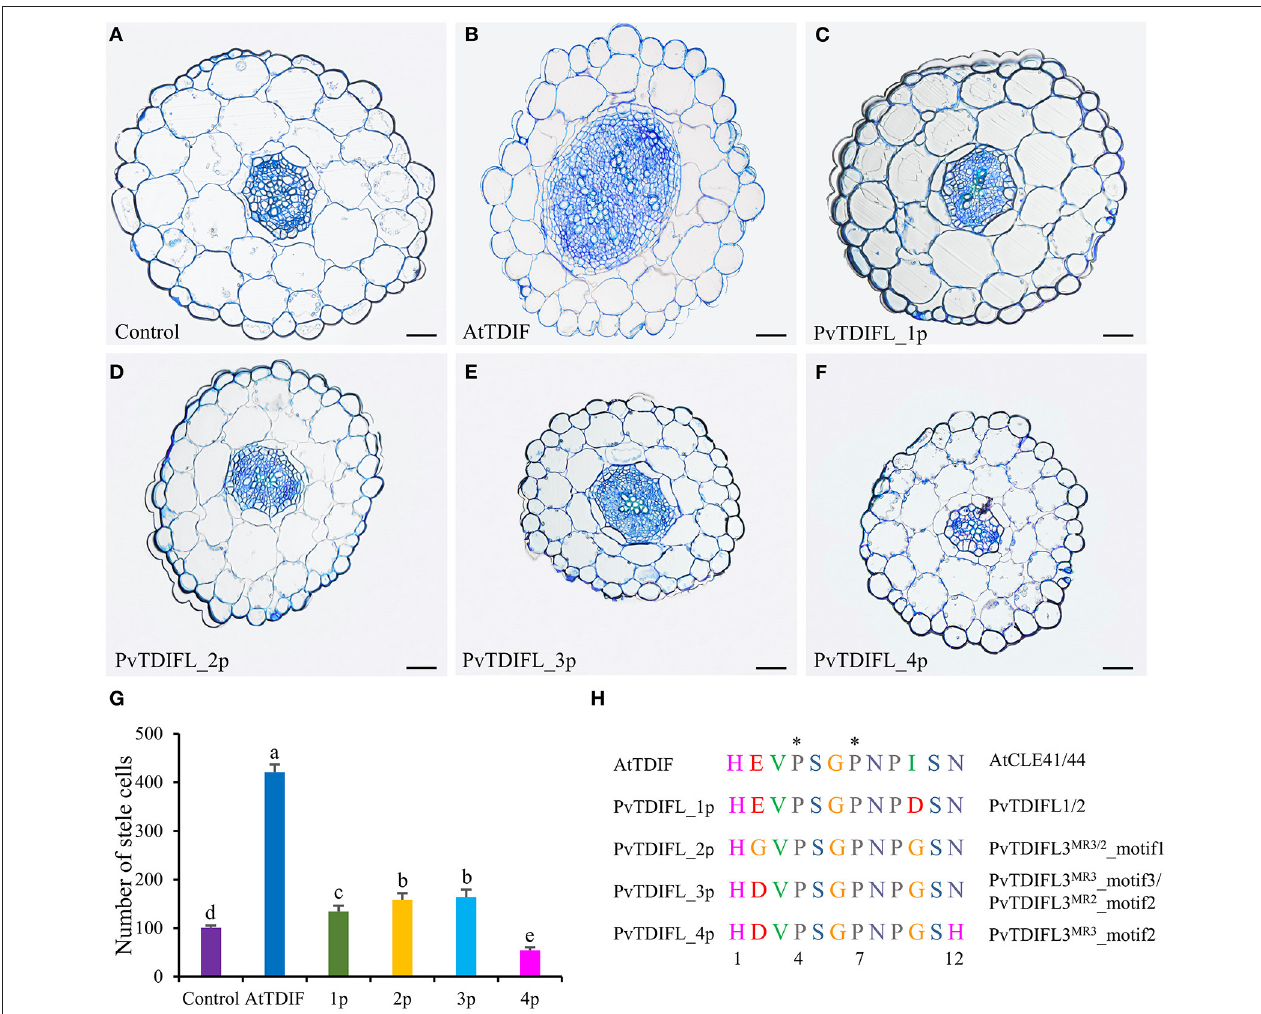
FIGURE 4 | Effects of AtTDIF and PvTDIFL peptides on stele development of 10-day-old Arabidopsis hypocotyls grown in liquid media. (A) Transverse section of hypocotyl from Arabidopsis plants without peptide-treatment. (B–F) Transverse sections of hypocotyls from Arabidopsis plants treated with the AtTDIF (B) , PvTDIFL_1p (C) , PvTDIFL_2p (D) , PvTDIFL_3p (E) , and PvTDIFL_4p (F) synthetic peptides. Sections were 2.5 µ m thick and stained with 0.05% (w/v) aqueous toluidine blue. Bar = 50 µ m. (G) Numbers of stele cells in the hypocotyls of non-treated and synthetic peptide-treated plants. Biological replicates were sections